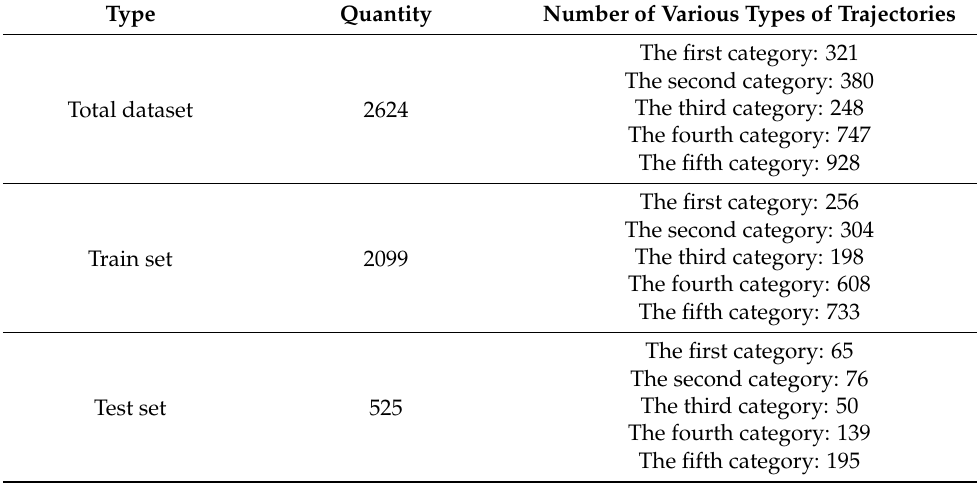
Table 3. Dataset